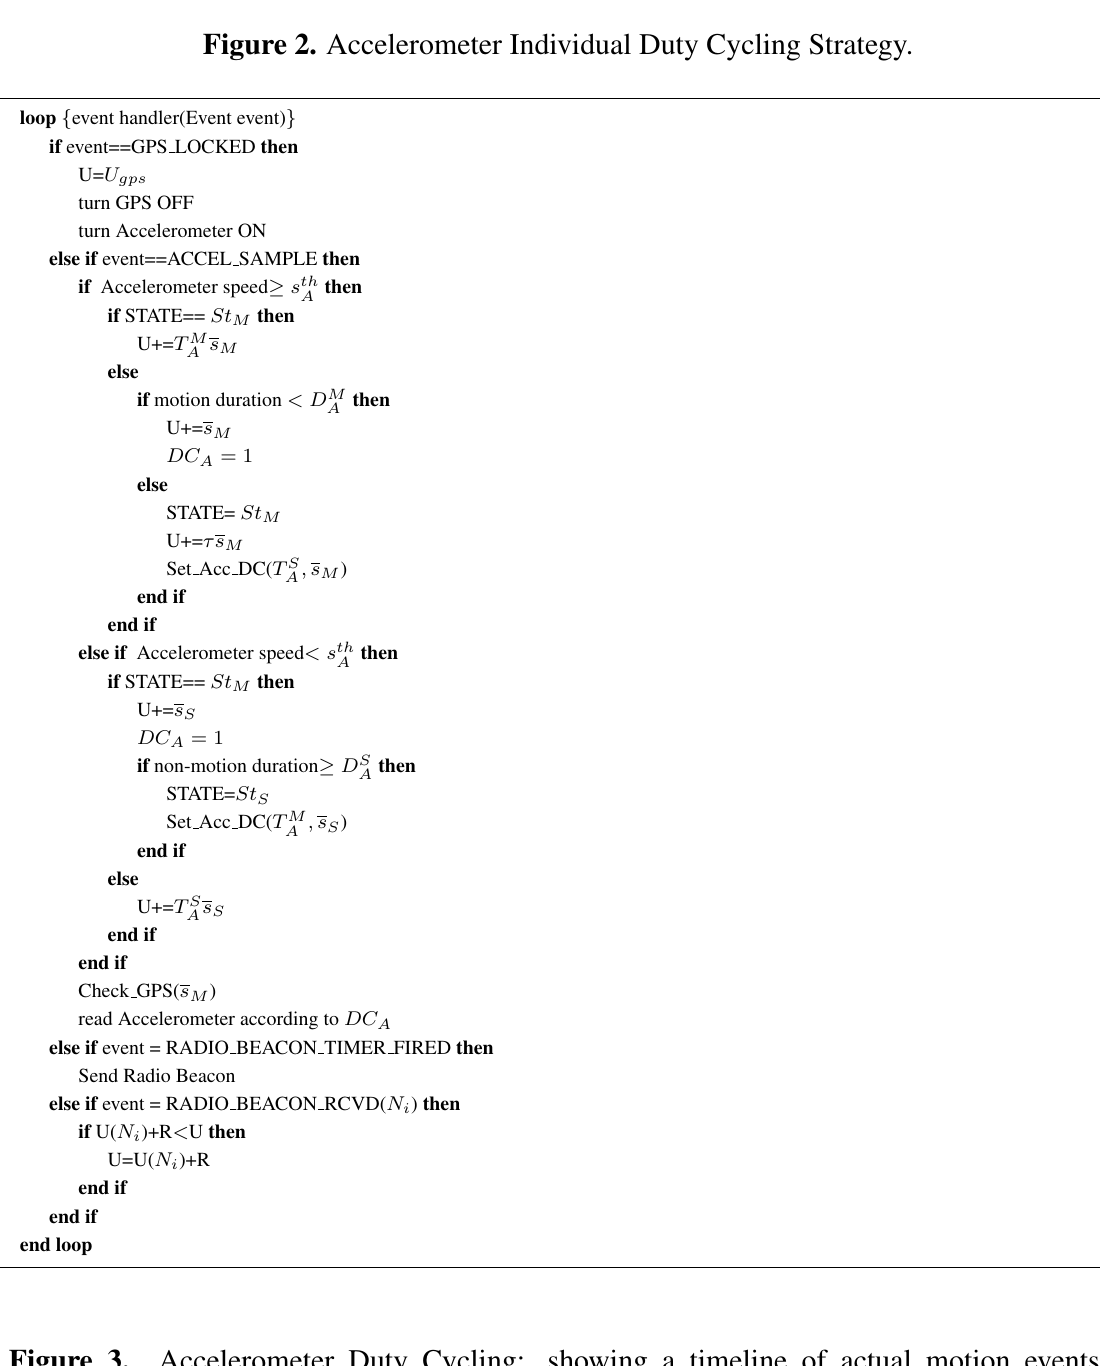
Figure 3. Accelerometer Duty Cycling: showing a timeline of actual motion events, algorithm state, and the active/sleep periods of the accelerometer.